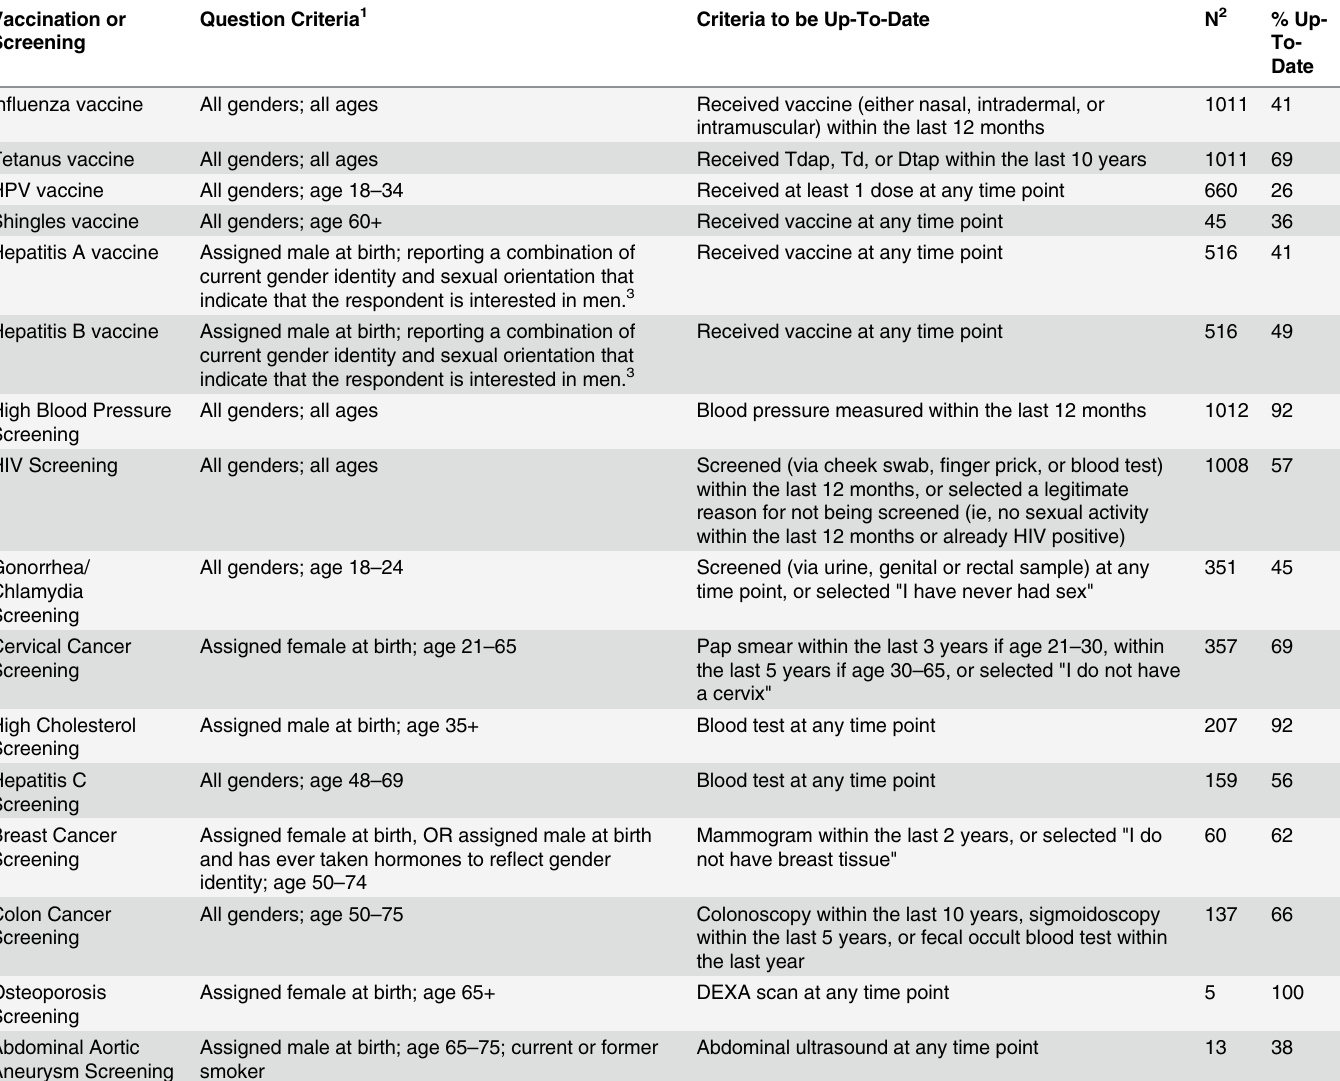
Table 4. Uptake of Recommended Health Screenings & Vaccinations of an online sample of rural LGBT people. Vaccination or